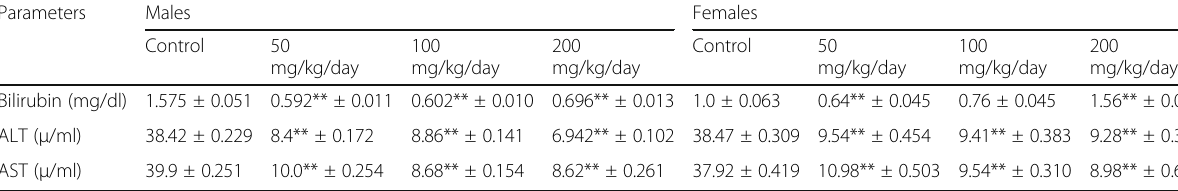
Table 4 Effect of different test doses of product on bilirubin, ALT and AST in male and female rats Parameters